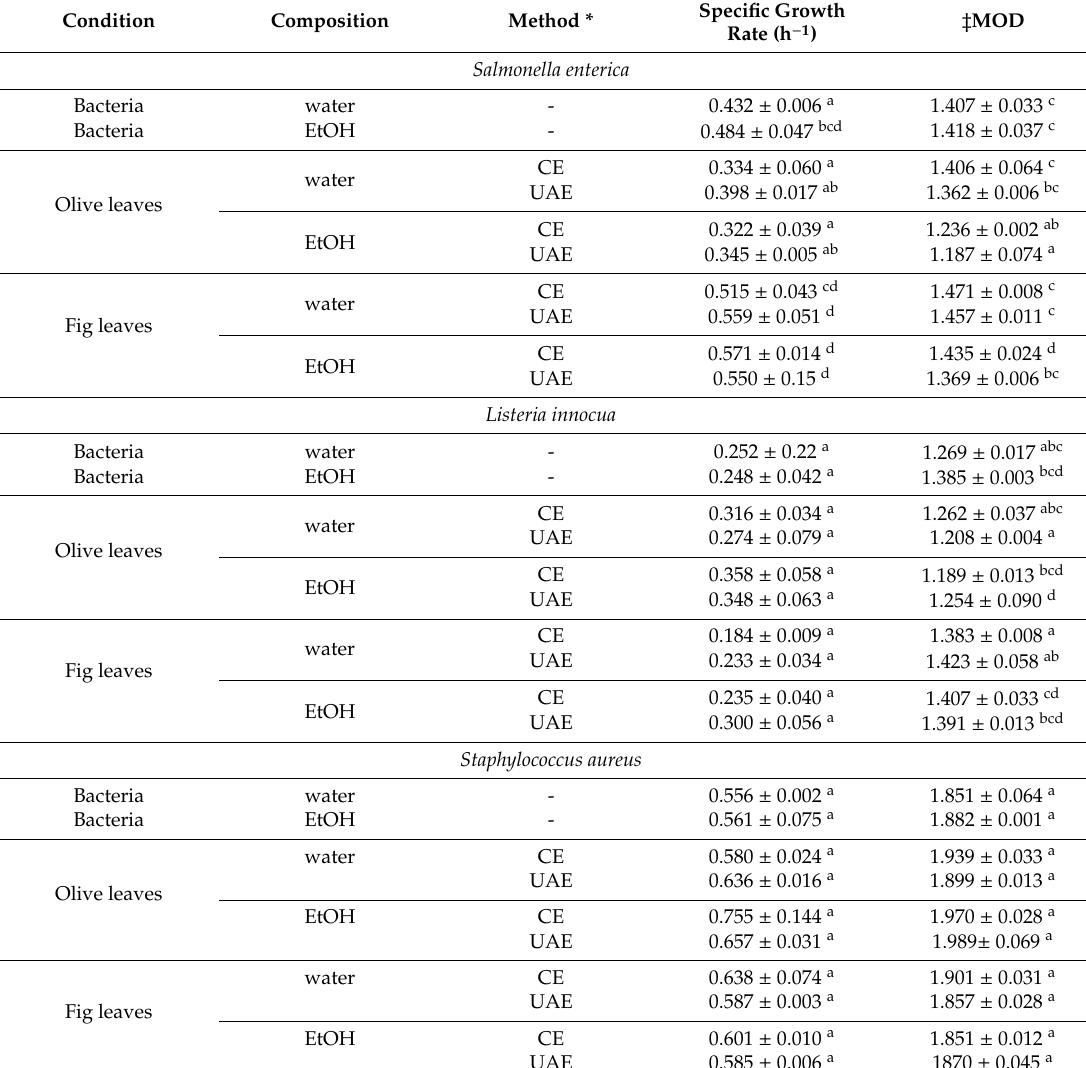
Table 3. E ff ect of olive and fig leaves extracts in the growth rate and maximal optical density of bacteria